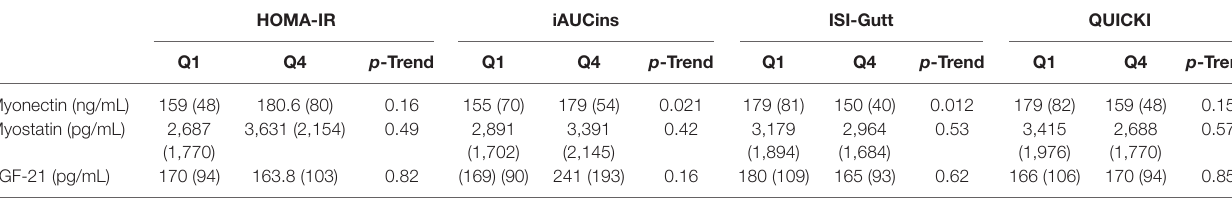
TaBle 4 | Mean values of plasma myokines across quartiles of insulin resistance and insulin secretion indices from the OGTT. hOMa-ir iaUcins isi-gutt